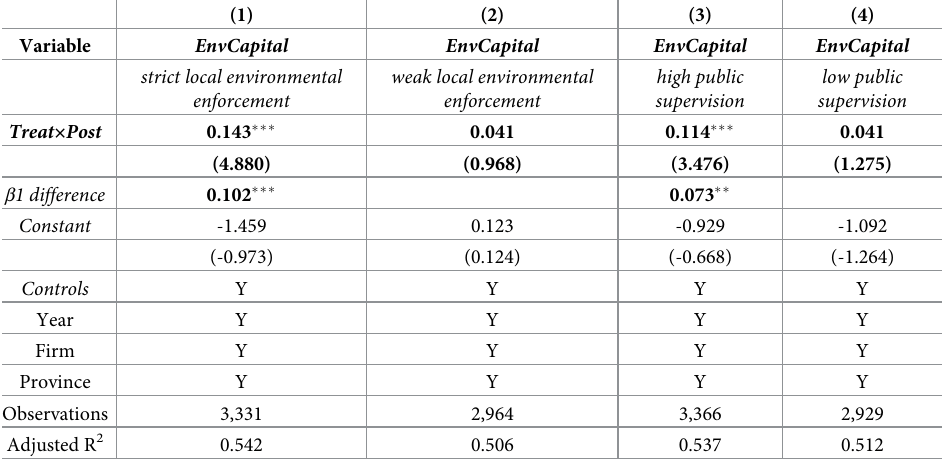
Table 8. Additional analysis: External legitimacy pressure.